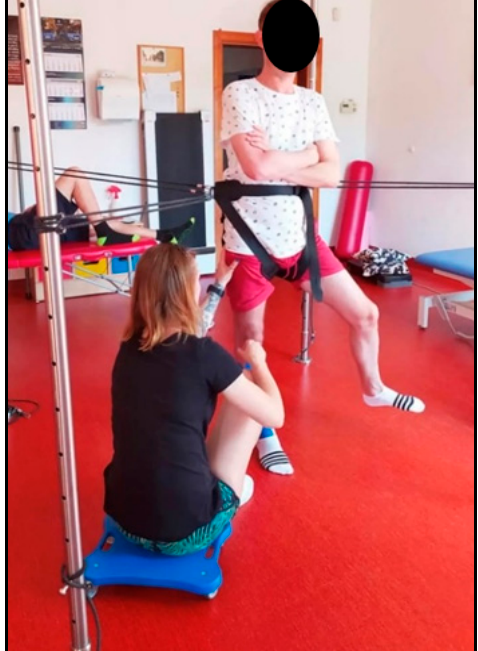
Figure 6. Patient II during therapy with usage of the SPIDER system (own source).